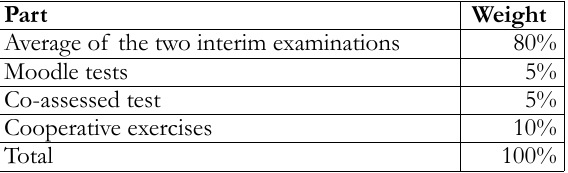
Table 1. The final mark through continuous assessment